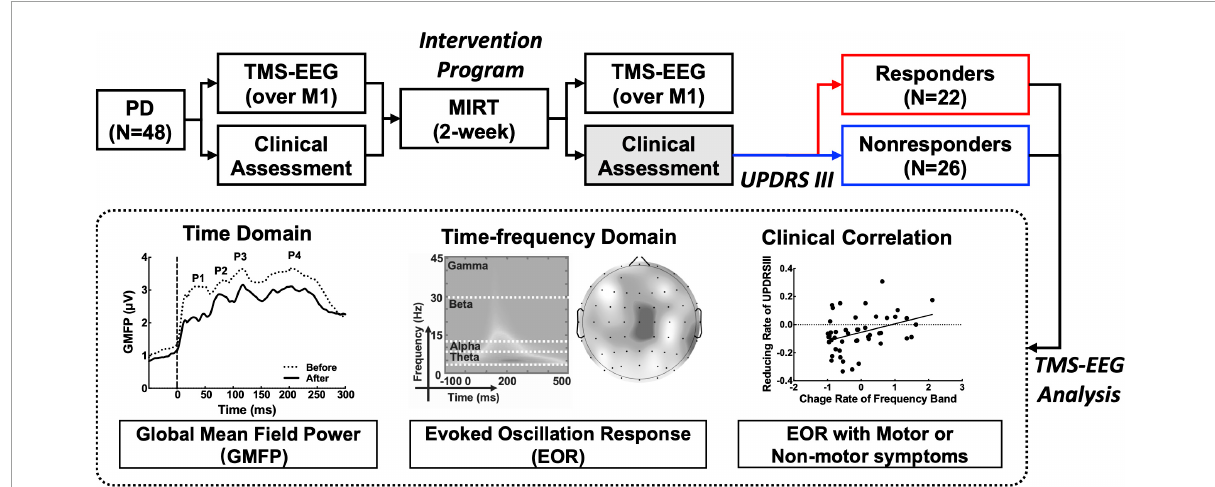
FIGURE1 Workflow of the Parkinson’s disease (PD) treatment design and transcranial magnetic stimulation and electroencephalography (TMS-EEG)